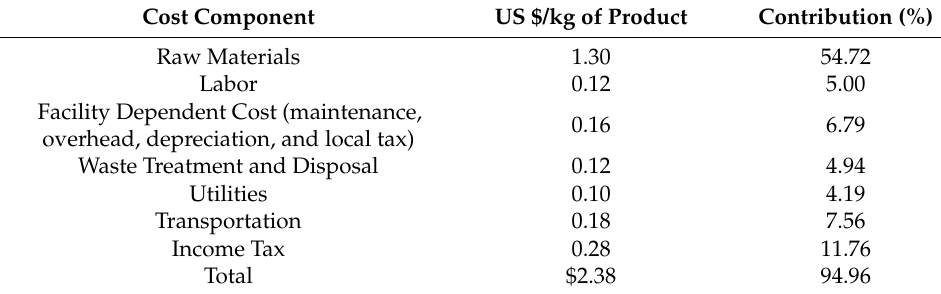
Table 8. Cost components of the minimum selling